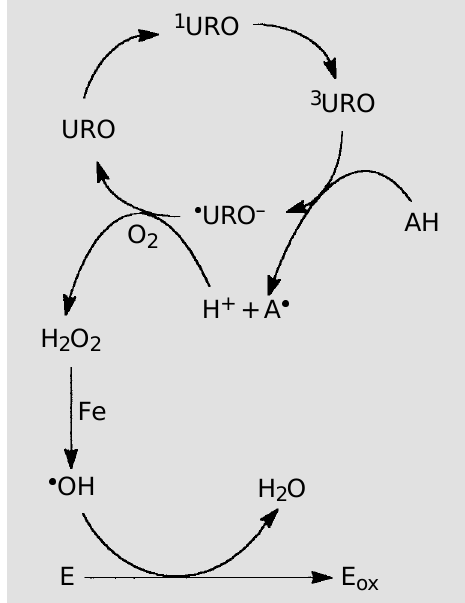
Figure 5 - Mechanism of uropor- phyrin action. URO: Uroporphy- rin in the ground state; 1 URO: singlet excited state uroporphy- rin; 3 URO: triplet excited state • URO - : anionic uroporphyrin; radical uroporphyrin; AH: elec- tron donor; E: native enzyme; E ox : photooxidized